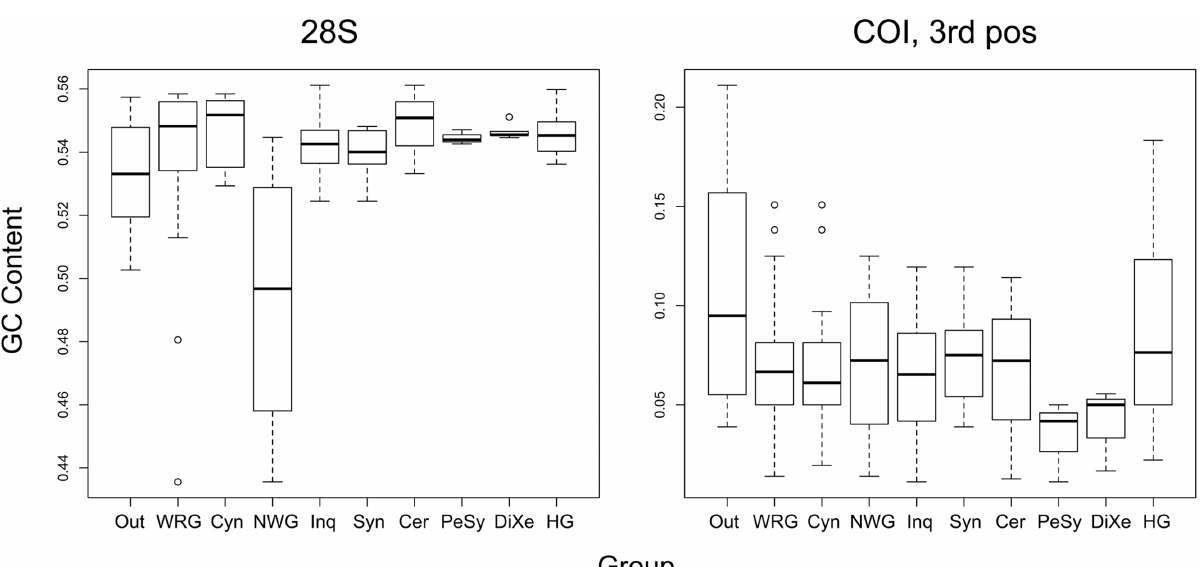
Fig 8. Base composition bias and cynipid phylogeny. GC composition bias across the tree is unlikely to explain why woody-rosid gallers and inquilines, supported as monophyletic in previous morphology-based analyses, do not appear as monophyletic groups in our analyses. To exemplify, we show the GC composition bias for 28S (left) and COI (right). For the latter, we only show the third codon position, containing almost all of the informative variation; the pattern was similar but less extreme for the other codon positions. The non-oak woody-rosid gallers (NWG) are more similar to the outgroups (Out) than to the Cynipini (Cyn) in GC content of 28S, possibly a convergent similarity explaining why the woody-rosid gallers (WRG) are not monophyletic in the 28S analysis. There is no such potential bias in COI but the WRG nevertheless fail to appear as monophyletic in separate analysis of this marker. For the inquilines, the pattern is the reverse. In COI, there is some heterogeneity in composition among inquilines (Inq), such that Periclistus and Synophromorpha (PeSy) deviate from the Synergini (Syn) and Ceroptresini (Cer). Similarly, Diastrophus and Xestophanes (DiXe) deviate from herb gallers (HG, including Aylacini, Aulacideini and Phanacidini). If the bias arose independently in the two groups, it could explain the support for Diastrophini in the COI analysis. There is no such bias in 28S but the Diastrophini nevertheless appear as monophyletic in analysis of this marker.